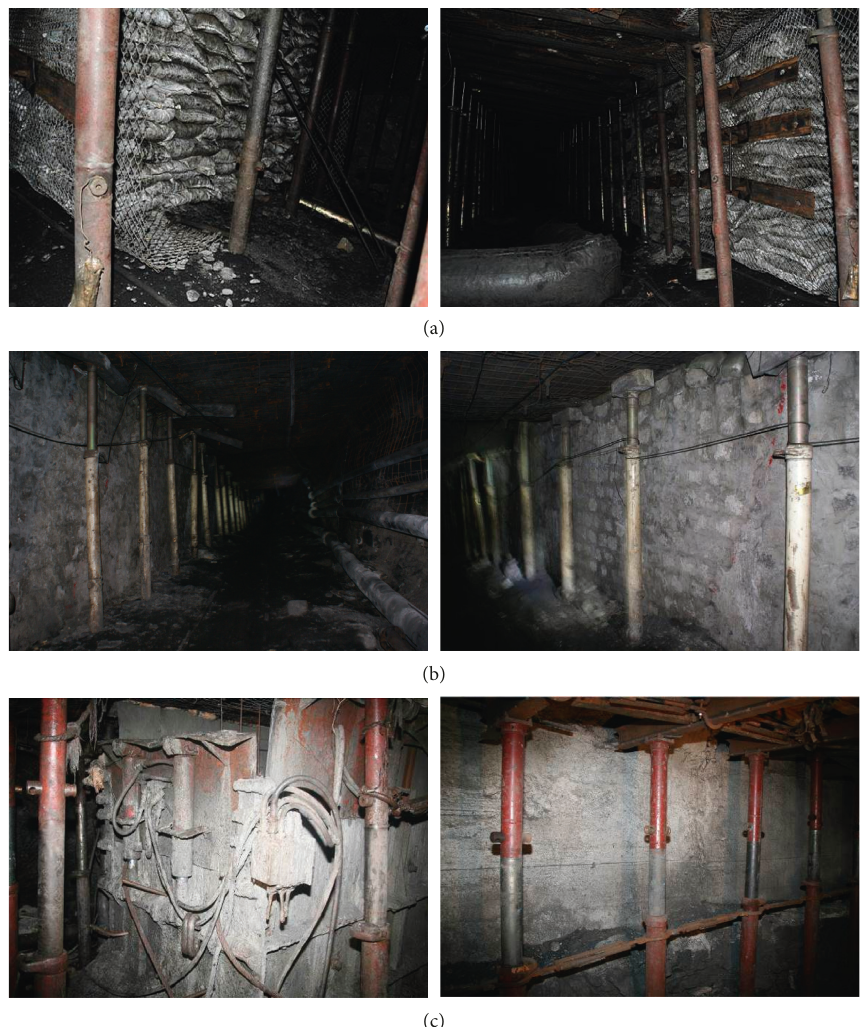
Figure 11: Different types of artificial wall for gob-side entry retaining: (a) stacking sacked gangue; (b) building concrete blocks; (c) pouring concrete or high-water material into the mould. In each panel, the picture on the left represents the construction of the artificial wall, and the picture on the right represents the completed